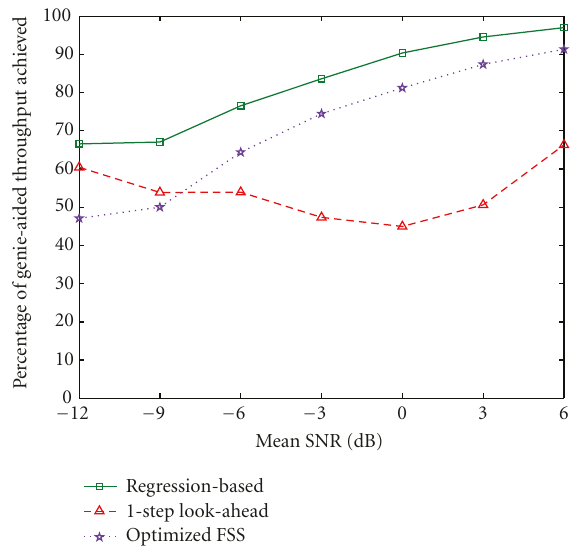
Figure 3: Evolution of the collision probabilities (a) and the Lagrange multipliers (b).